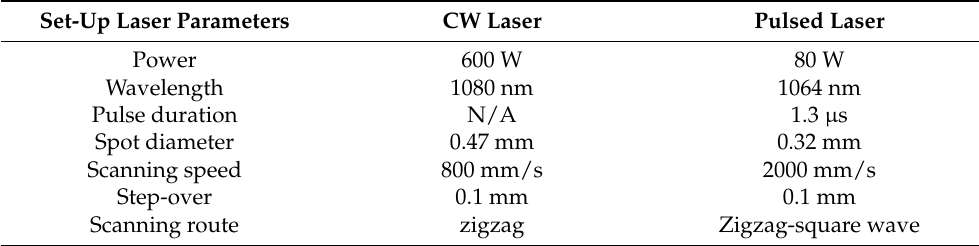
Figure 5. Dual-beam laser polishing system: ( a ) schematic diagram of the EOS M290 LPBF system, ( b ) photograph of dual-beam laser polishing system. Table 3. Parameters of the dual-beam laser polishing.